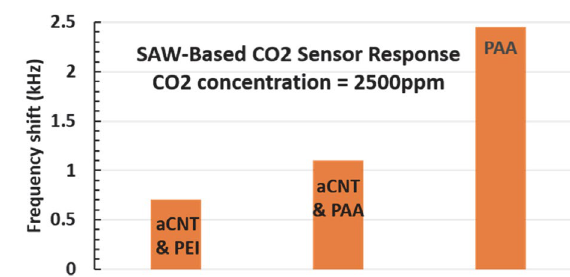
Figure 3. Frequency shifts at 2500 ppm CO 2 concentration for dif- ferent sensing layers used to coat SAW